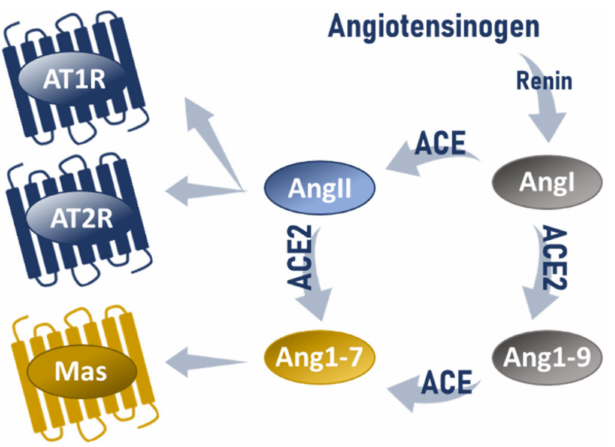
Figure 1. RAS cleavage cascade and the principal receptors of Ang II and